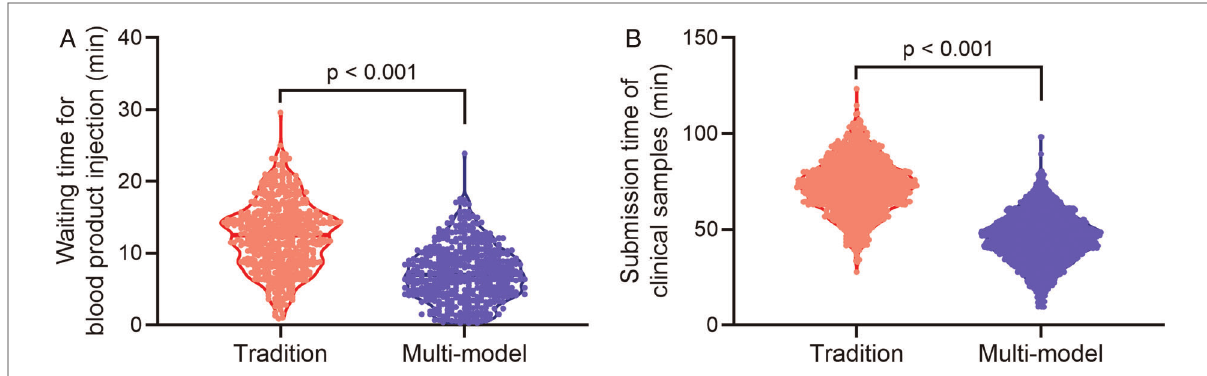
FIGURE 1 Comparison of waiting time for blood product injection ( A ) and submission time of clinical samples ( B ) between traditional process group (tradition) and multimodal practice group (multi-model). Violin plot. Mann – Whitney test.